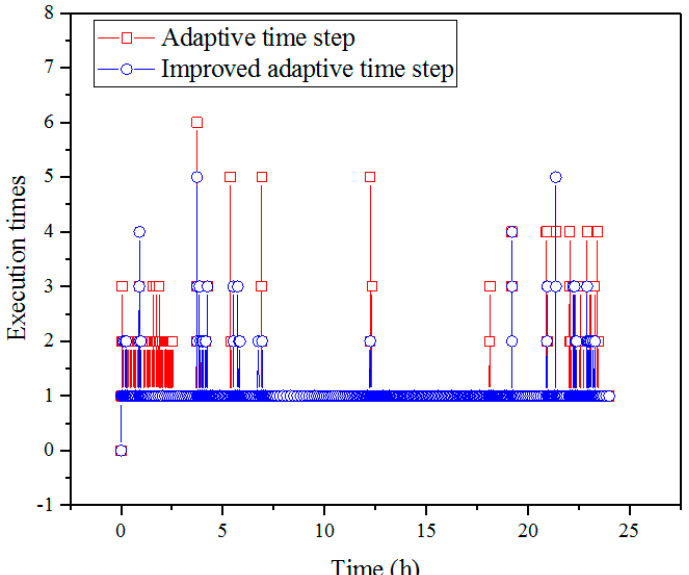
Figure 9. Execution time versus time. For the 24 h transient simulation process, the total times and time levels of the time step adjustment program executed by both methods are shown in Table 7. The total number of executions indicates the total number of times that Step 1 was performed. In addition, the number of time levels means the total number of time levels for completing the 24 h simulation. Since simulation needs to be performed at least once at each time level, the difference between the total number of executions and the time levels indicates extra executions when the time step is adjusted during the 24 h simulation process. Table 7. Total execution and total time levels. Total Number of